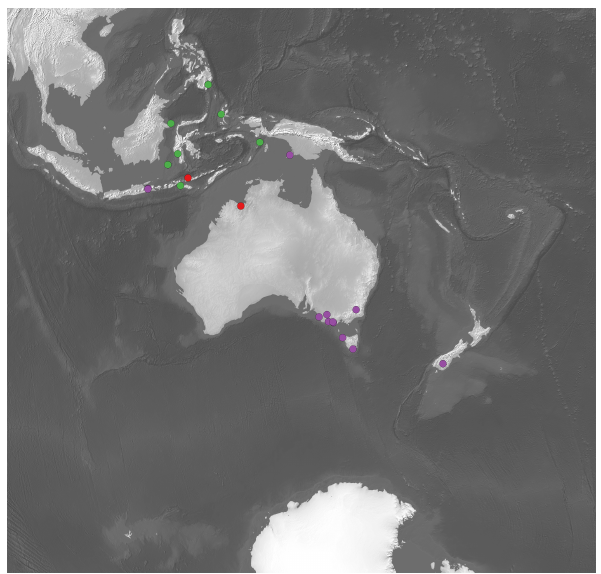
Figure 3. Locations of high-quality Aus2k records. Each marker represents one record location. Archive types are represented by colour for lake/wetland (purple), marine (green), speleothem (red), and geomorphic (blue) archive